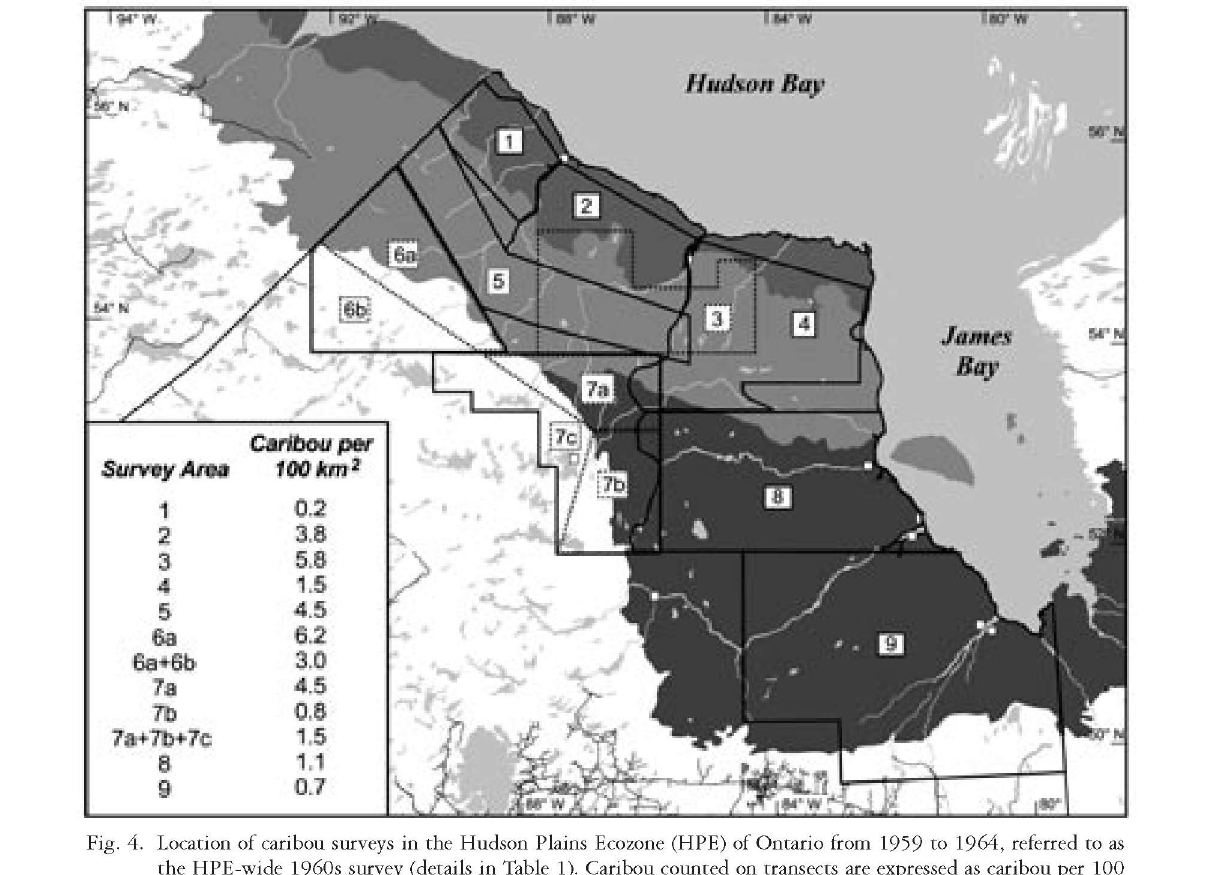
Fig. 4. Location of caribou surveys in the Hudson Plains Ecozone (HPE) of Ontario from 1959 to 1964, referred to as the HPE-wide 1960s survey (details in Table 1). Caribou counted on transects are expressed as caribou per 100 km 2 of transect area (see Table 1 for references to the original survey reports).